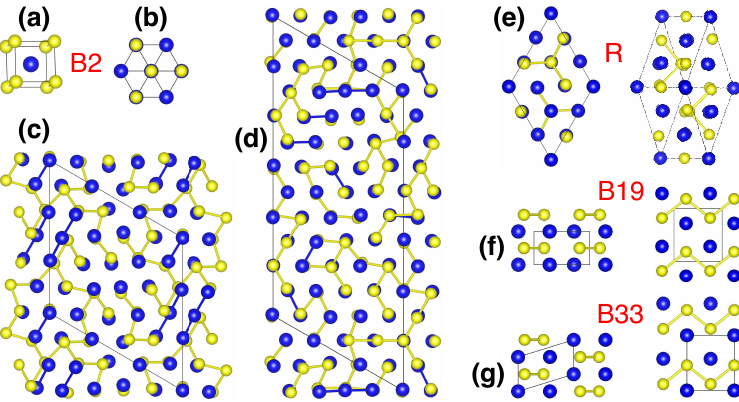
Figure 6. (color online). ( a ) Ideal B2 (or CsCl) structure and ( b ) its [111] projection, with Ni (yellow) and Ti (blue) atoms; length of NN (Ni–Ti) bonds is 2.6 Å, NNN (Ni–Ni or Ti–Ti) bonds are 3.0 Å. Stable atomic positions in cubic B2 [111] projection are shown in representative supercells (bounded by thin black line), containing ( c ) 54 atoms and ( d ) 108 atoms; for view of projections in 54-atom supercell, see Figure 1 in [20]. The NNN Ni–Ni and Ti–Ti bonds shorter than 2.75 Å (or 2.7 Å in B19) are shown. ( e ) The kinetically limited unstable intermediate R structure (suggested from experiment [45]) is shown in cubic [111] (or hex [001]) projection ( left ) and cubic [100] (or hex [111]) projection ( right ). Shown in [001] ( left ) and [100] ( right ) projections are ( f ) the unstable B19 and ( g ) the BCO B33 ground state. The orthorhombic B19 and B33 structures can be viewed as monoclinic B19’ with a shear angle θ of 90 ◦ and ≈ 107 ◦ , respectively.